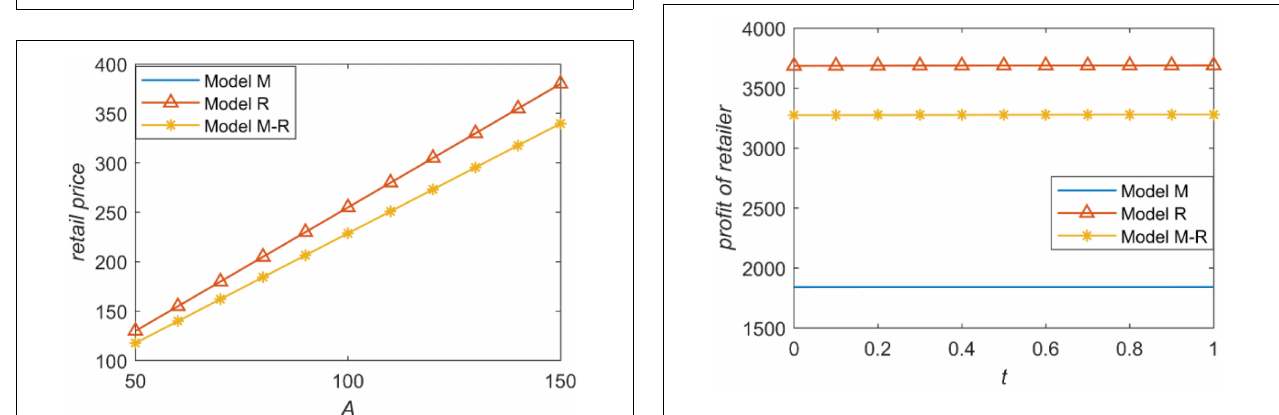
FIGURE 2 | The wholesale price with forecast demand.